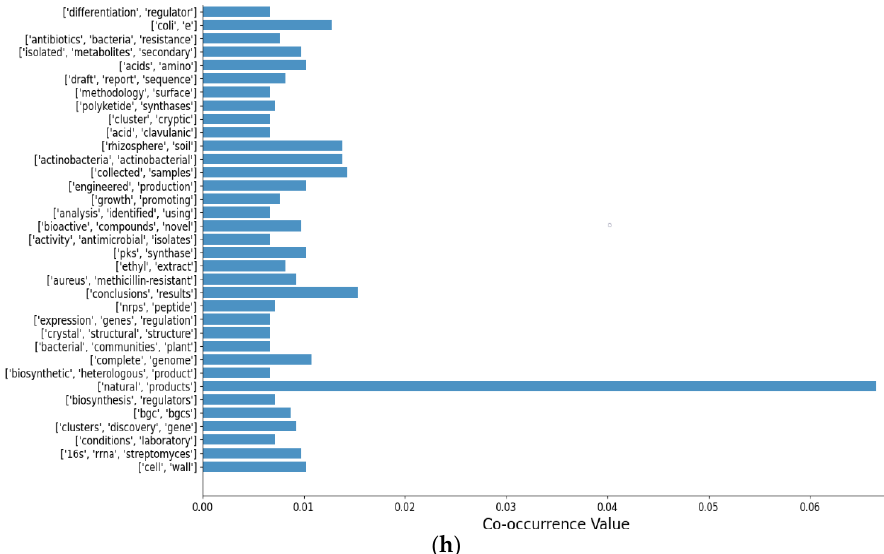
Figure 3. Resultant sets with co-occurrence value for: ( a ) amikacin; ( b ) ethambutol; ( c ) isoniazid; ( d ) linezolid; ( e ) moxifloxacin; ( f ) pyrazinamide; ( g ) rifampicin; ( h ) streptomycin.